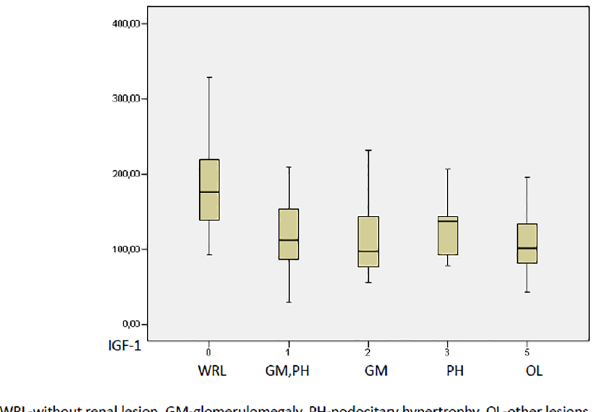
Fig 2. IGF-1 levels in patients without renal lesion and with different types of renal. Univariate and multivariate logistic regression models were used to analyze variables such as SBP, DBP, BMI, creatinine clearance, glucose, HOMA-IR, HS-CRP, and ADPN in our study population. The presence of a glomerular lesion was defined as the dependent variable. Univariate analysis revealed that the presence of a glomerular lesion was associated with a low IGF-1 SDS and